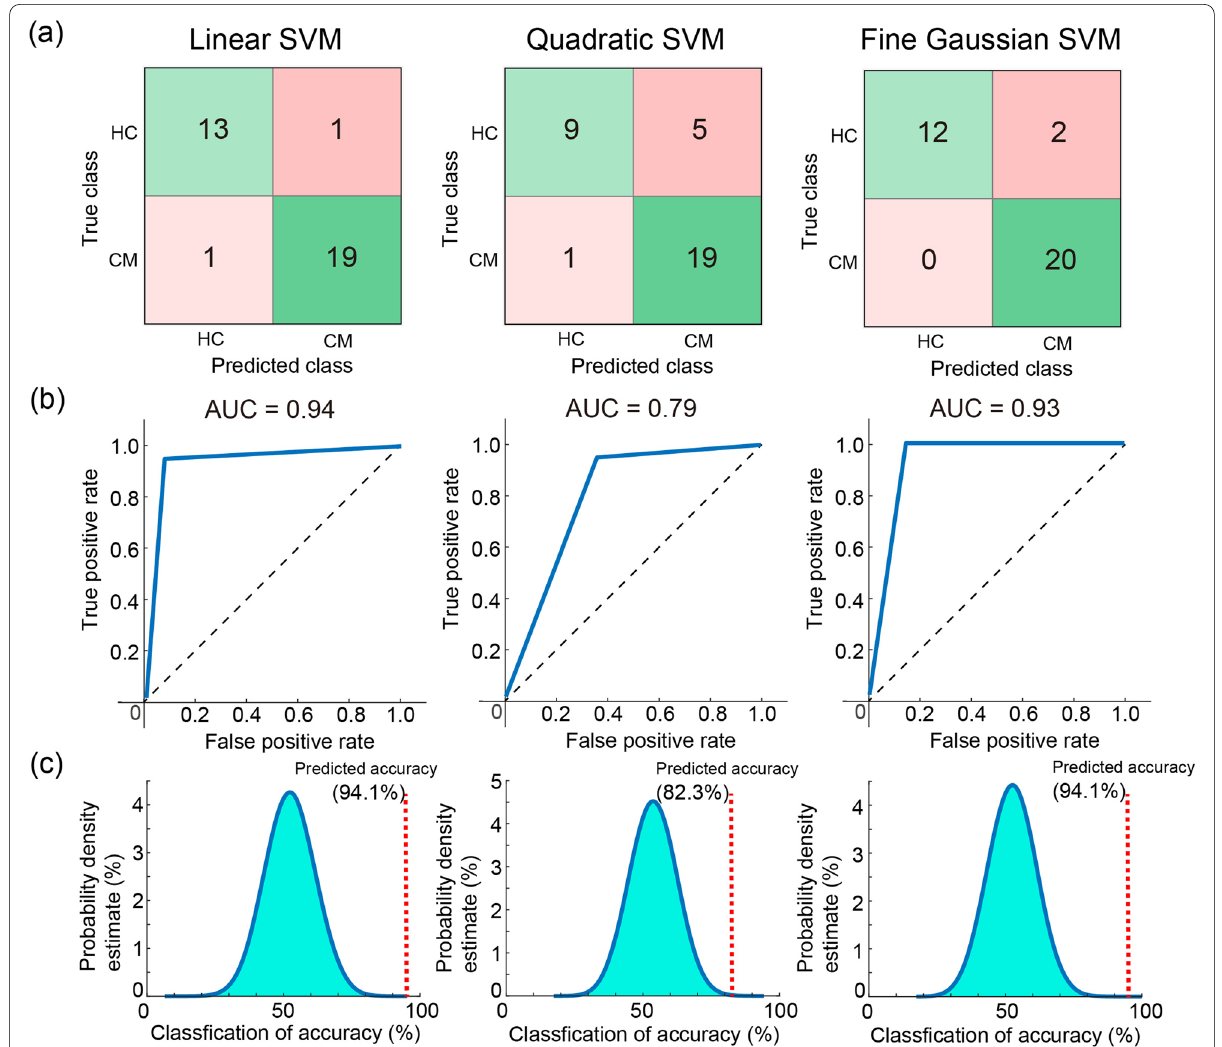
Fig. 4 a Confusion matrix, ( b ) area under the curve (AUC), and overall prediction accuracy (permutation test) of machine learning analysis with three kernels for classifying chronic migraine (CM) from healthy controls (HC) in the independent testing data set. SVM, support vector